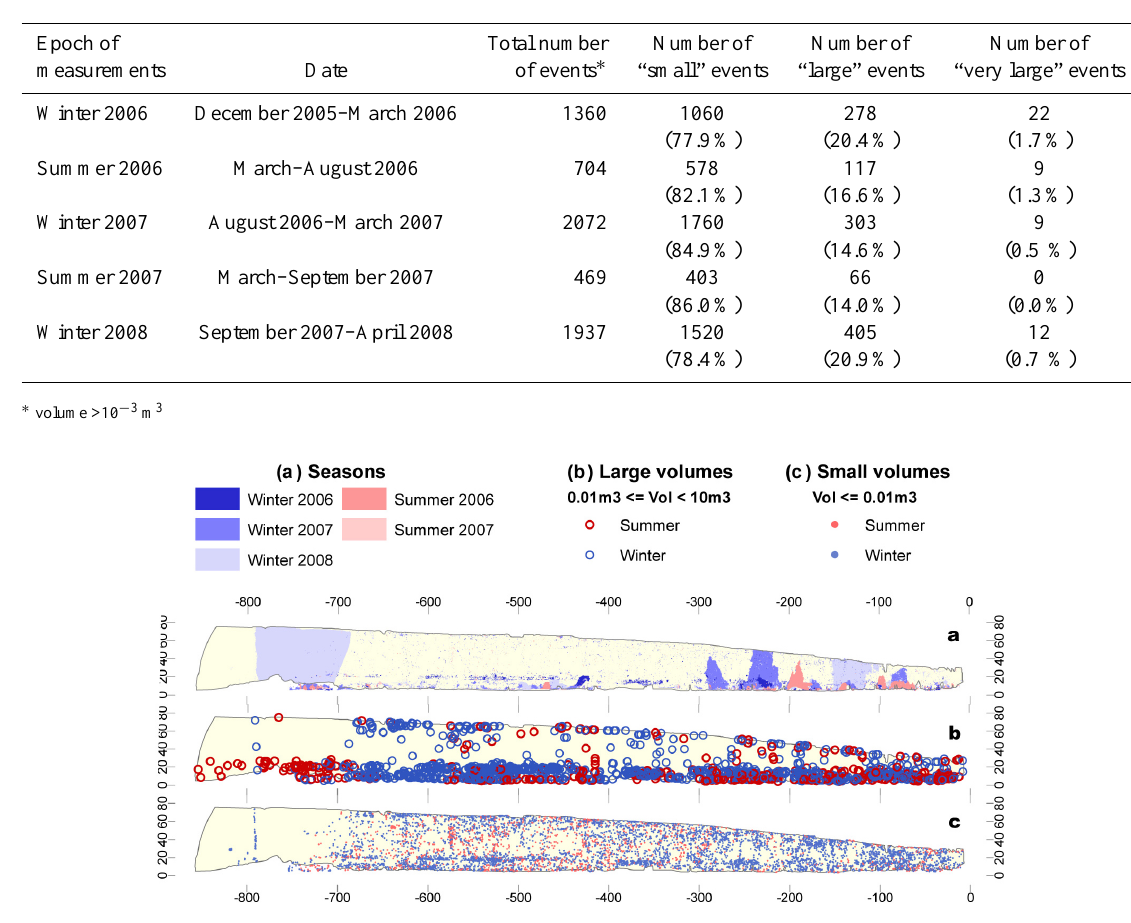
Table 1. Inventories of erosion scars collated at different epochs of measurement: “small” events correspond to a volume range [10 − 3 to 10 − 2 m 3 ], “large” events correspond to a volume range [10 − 2 to 10 1 m 3 ], “very large” events have volumes larger than 10 1 m 3 . The total number of events corresponds to all events with volume above 10 − 3 m 3 .